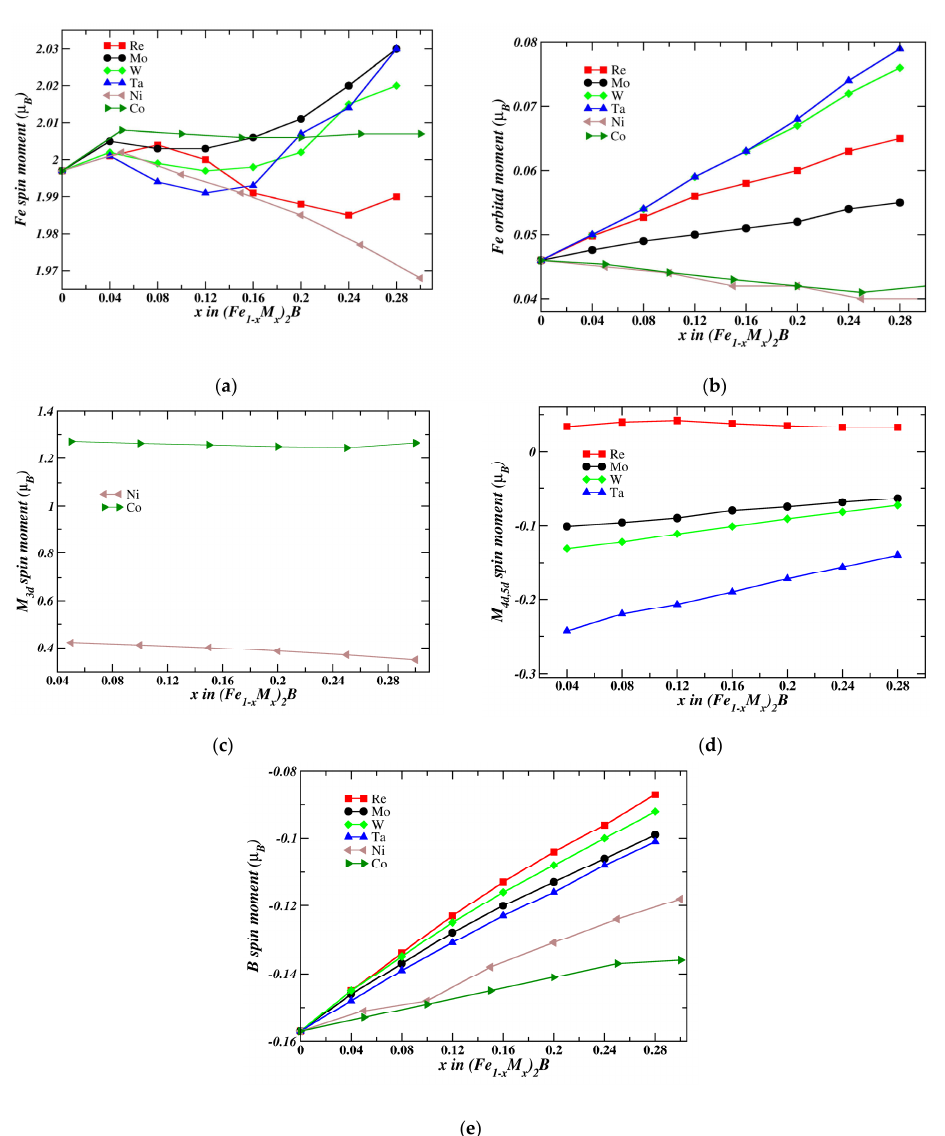
Figure 3. The dependence of the spin and orbital moments of Fe ( a , b ), M ( c , d ) and B ( e ) vs. doping content x in the (Fe 1 − x M x ) 2 B alloys. Doping with 3d elements with smaller spin-orbit coupling reduces the orbital mo- ments of Fe, whereas an increase of m l is obtained by doping with 4d / 5d elements, which is more pronounced for 5d elements (Ta, W and Re). The spin magnetic moments of Co and Ni within the (Fe 1 − x M x ) 2 B alloys are repre- sented in Figure 3c vs. the doping amount x. The Co spin moment (~1.28 µ B ) is almost independent of the doping content, whilst the m s of Ni ranges between 0.42 and 0.38 µ B , decreasing with x. The non-magnetic 4d / 5d doping elements (Figure 3d) have small in- duced negative spin moments between − 0.1 and − 0.25 µ B (M = Ta, W and Mo) or small positive induced magnetic moments up to 0.04 µ B (M = Re), slightly dependent on the doping content. The boron spin moment vs. doping content x (Figure 3e) shows its nega- tive polarization, which is reduced by an increase of doping amount x and is more pro- nounced for 5d elements (Re and W) and less pronounced for Co and Ni doping. The M and B orbital moments doping dependencies are negligible and not shown. The total magnetic moments for (Fe 1 − x M x ) 2 B alloys (M = Co, Ni, Mo, W, Ta and Re) have been used to calculate the magnetization µ 0 M s , shown in Figure 4. As expected, the 3d magnetic elements (Co and Ni) have less impact on the magnetization of (Fe 1 − x M x ) 2 B alloys, but Co is more e ff ective in keeping the large magnetization needed for a permanent magnet. On the other hand, doping with non-magnetic 4d and 5d elements induces a stronger decrease in magnetization. Between the 4d and 5d elements, doping with Ta